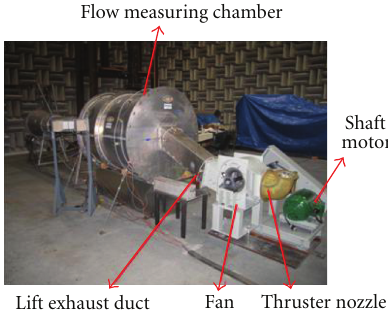
Figure 20: Centrifugal fan test